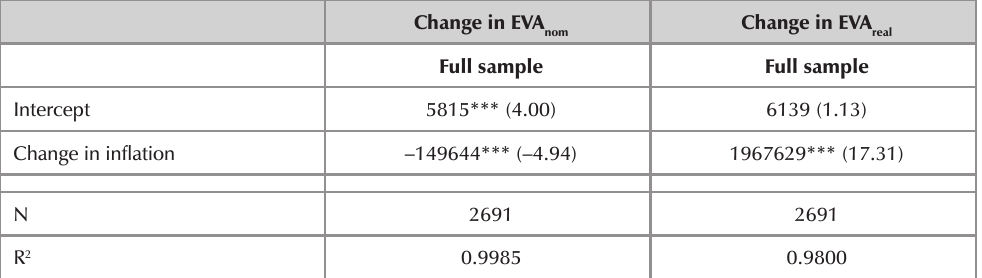
Regression analyses of change in EVAreal and EVAnom, and changes in